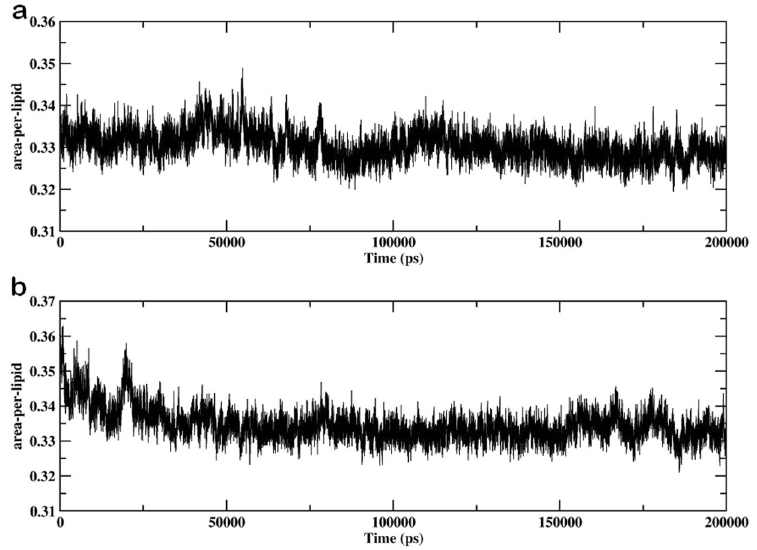
Figure 3. Evolution of area per lipid for ( a ) MEMB_12.5 ( b ) MEMB_50 system.